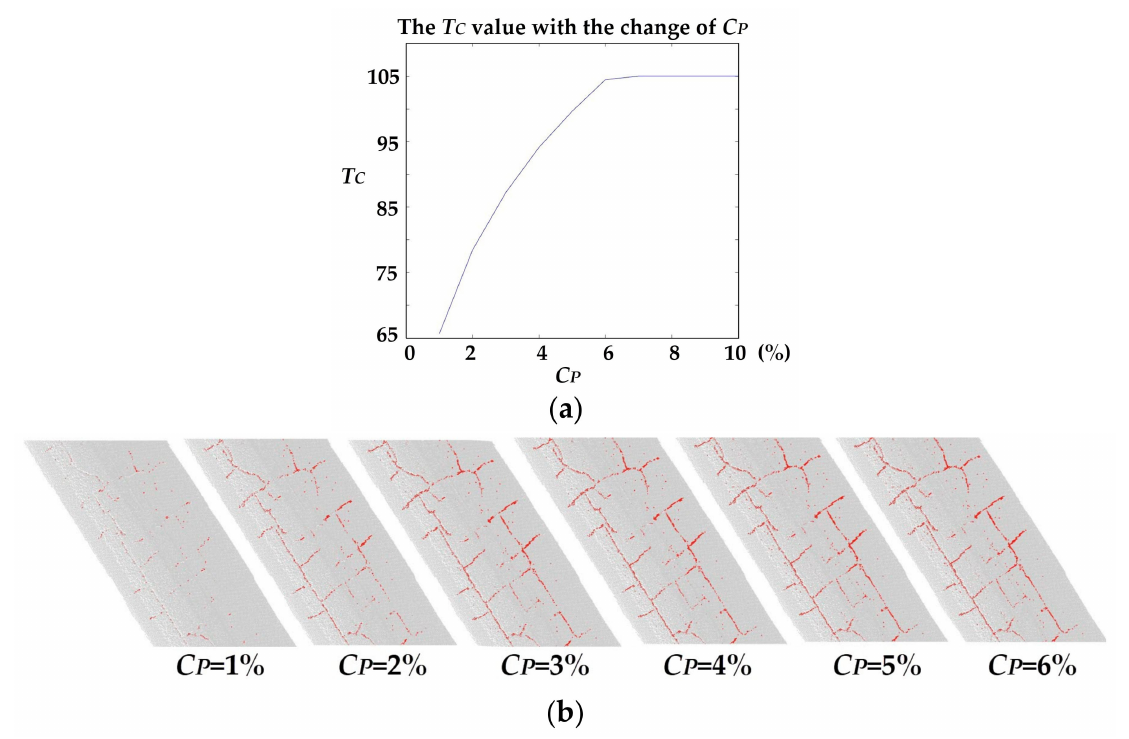
Figure 16. The sensitivity test of the C P with T C . ( a ) The change of the value of T C with C P , and ( b ) crack candidates corresponding to the selected C P